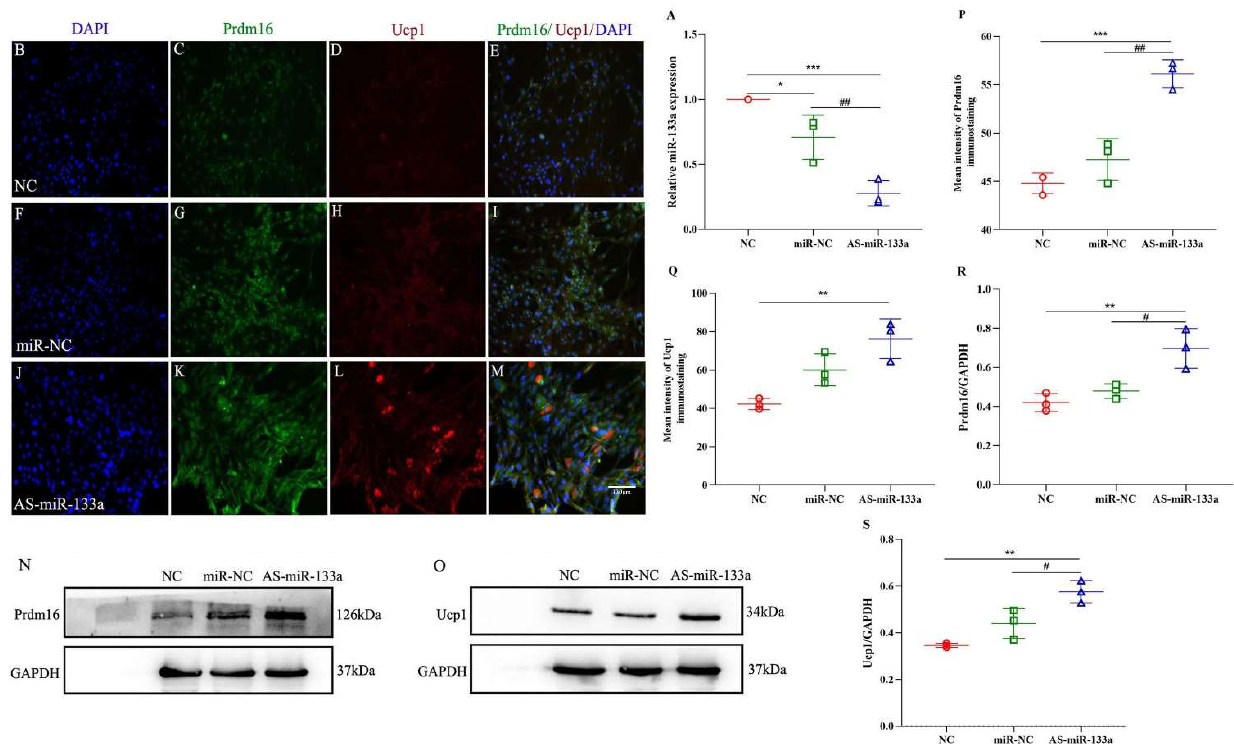
Figure 6. Immunoreactivity of Prdm16/Ucp1 proteins after the inhibition of miR-133a expression. ( A ) The expression levels of miR-133a in fully differentiated adipocytes treated with 5-aza and transfected with or without miR-133a inhibitor. ( B – M ) Increased immunoreactivity of Prdm16 (green) and Ucp1 (red) in fully differentiated adipocytes treated with 5-aza and transfected with or without miR-133a inhibitor (n = 3/group; blue, DAPI). ( N , O ) Expression of Prdm16 and Ucp1 in fully differentiated adipocytes treated with 5-aza and transfected with or without miR-133a inhibitor using Western blotting. ( P , Q ) Quantified changes in Prdm16 and Ucp1 in fully differentiated adipocytes treated with 5-aza and transfected with or without miR-133a inhibitor. ( R , S ) Normalized intensity of Prdm16 and Ucp1 relative to GAPDH, presented as the mean ± SD (n= 3). * p < 0.05, ** p < 0.01, *** p < 0.001 compared with the control group; # p < 0.05, ## p < 0.01 compared with other groups; bar = 130 µm. Prdm16, PR domain containing 16; Ucp-1, uncoupling protein-1; miR-133a, microRNA-133a; 5-aza-dC, 5-aza-2′-deoxycytidine.